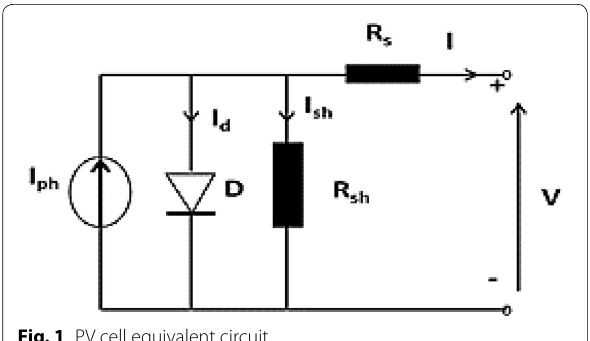
Fig. 1 PV cell equivalent circuit